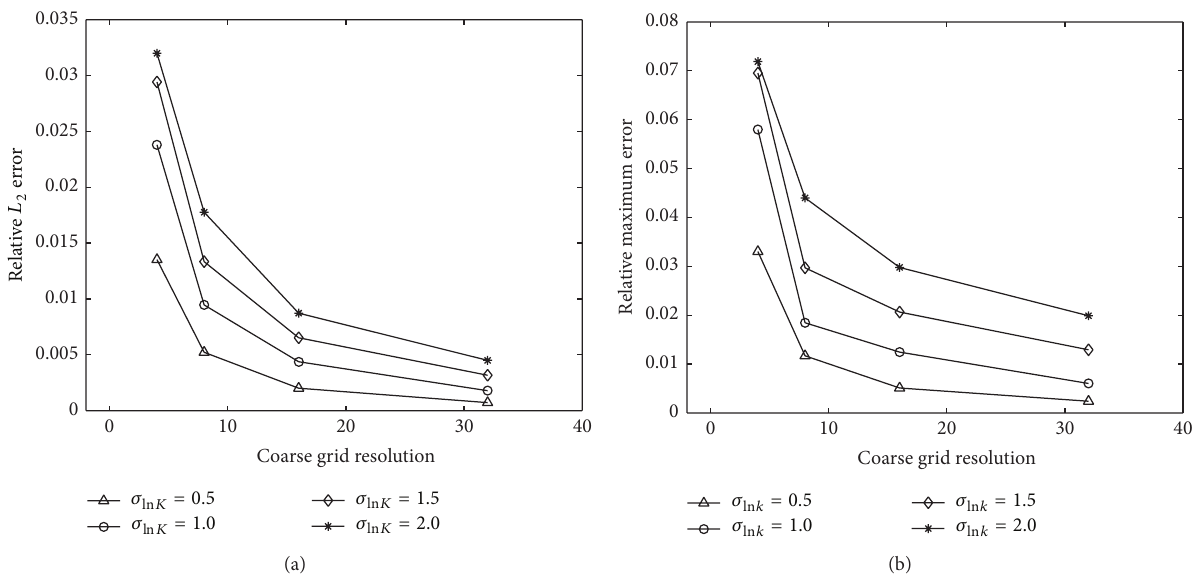
Figure 7: Relative (a) 𝐿 2 and (b) maximum errors of the solution of the new scheme for coarse grids with 4 × 4 , 8 × 8 , 16 × 16 , and 32 × 32 elements.